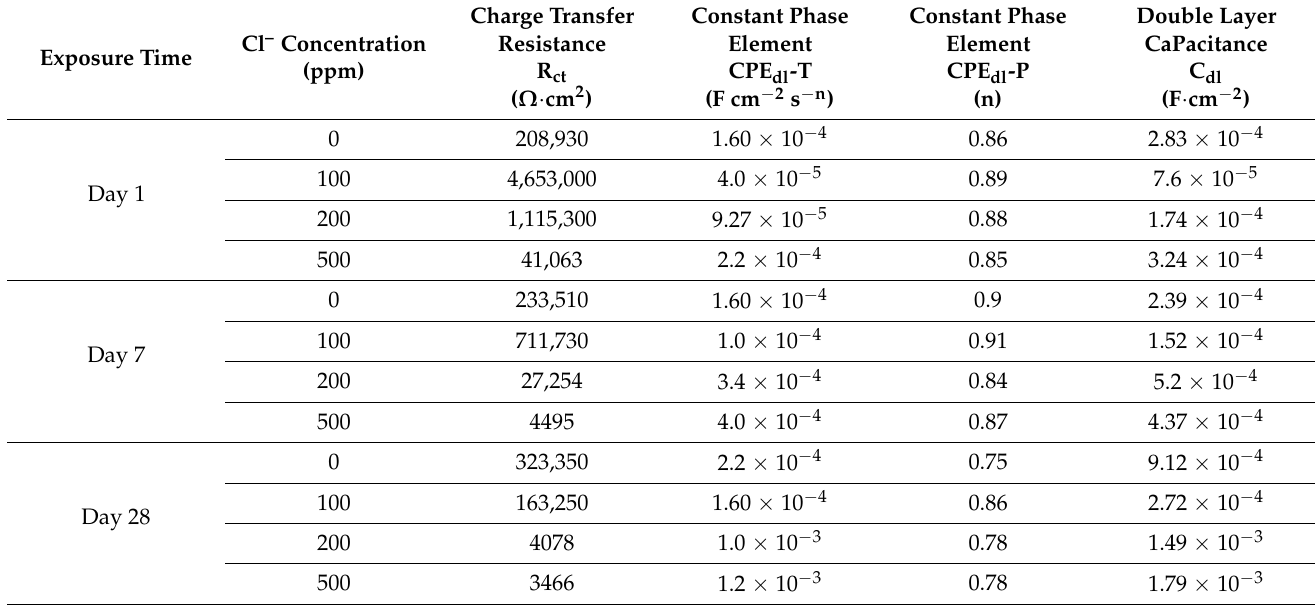
Table 4. Summary of electrochemical parameters extracted from EIS analysis of cast iron samples post exposure to various engine coolant